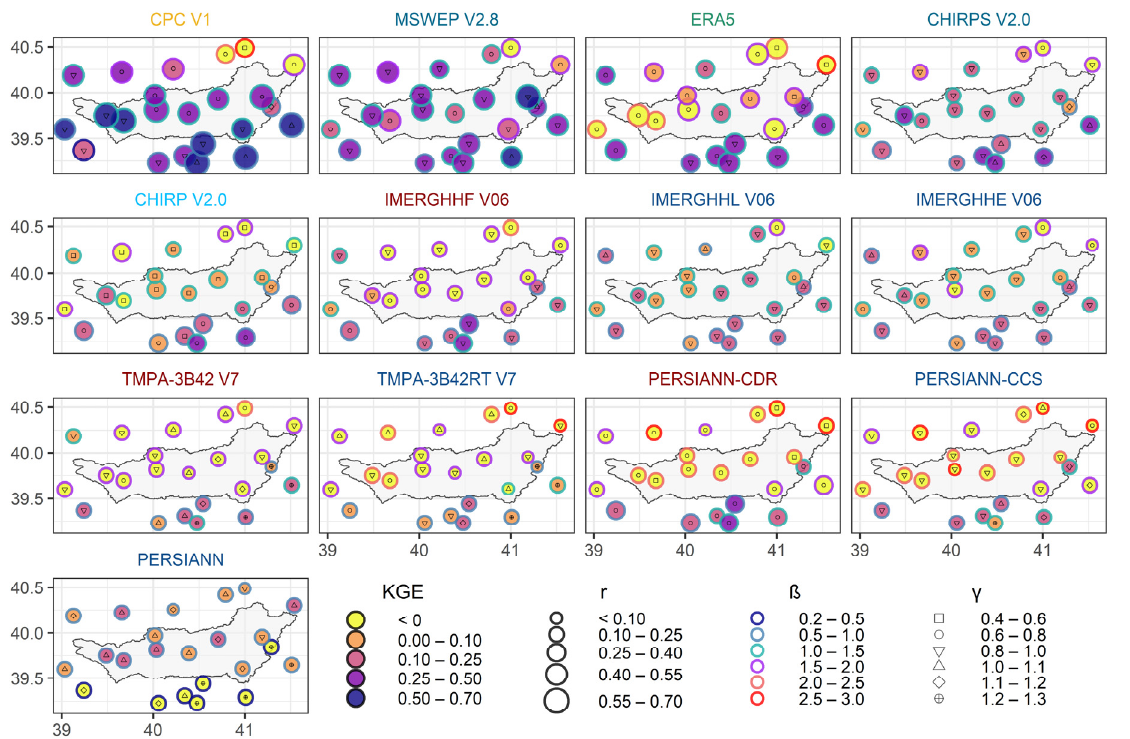
Figure 5. Spatial distribution of KGE and its correlation, bias, and variability ratio components at a daily time step over the Karasu river basin for 13 GPDs. The title color presents the source (s) of GPDs: satellite-based (blue), gauge and satellite (red), reanalysis and satellite (sky blue), reanalysis (green), reanalysis, ground, and satellite (steel blue), and ground (yellow).